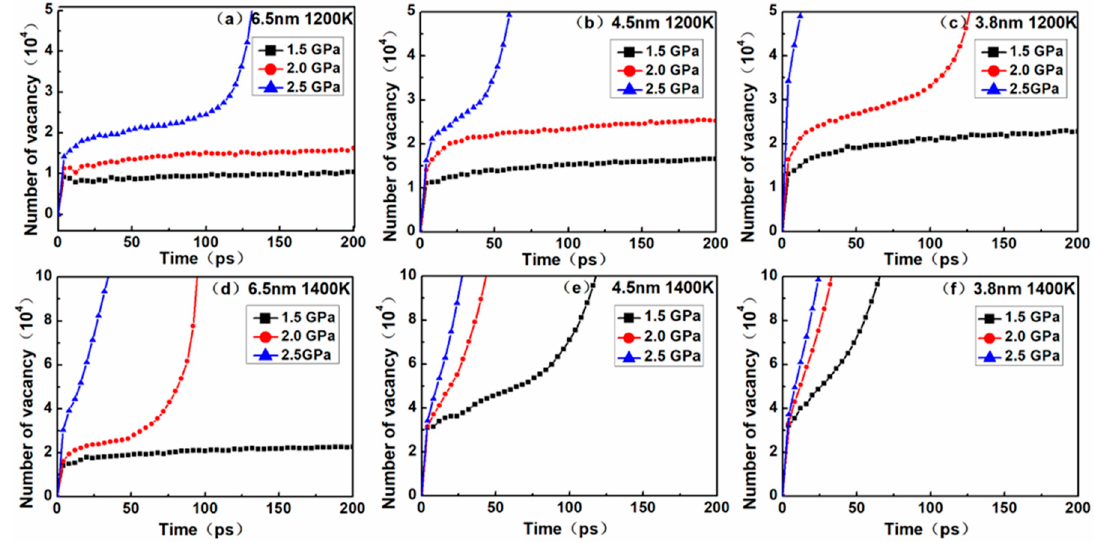
Figure 7. Plots of the vacancy versus time for the nanocrystalline NiAl models with di ff erent grain sizes of ( a ) 6.5 nm at 1200 K; ( b ) 4.5 nm at1200 K; ( c ) 3.8 nm at 1200 K; ( d ) 6.5 nm at 1400 K; ( e ) 4.5 nm at 1400 K; ( f ) 3.8 nm at 1400 K under the stress levels of 1.5, 2.0 and 2.5